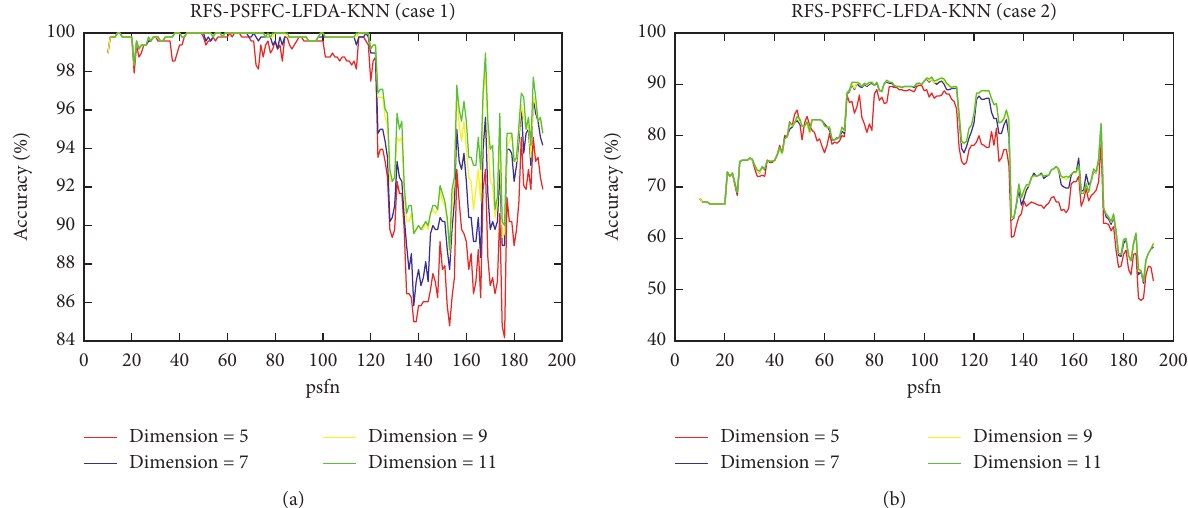
Figure 16: The testing accuracies of RFS-PSFFC-LFDA-SVM.